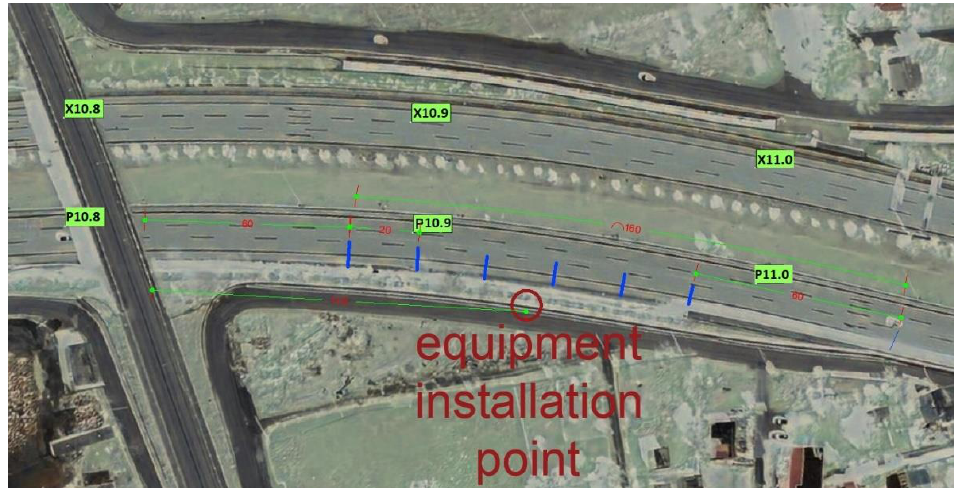
Figure 7. The installation site.